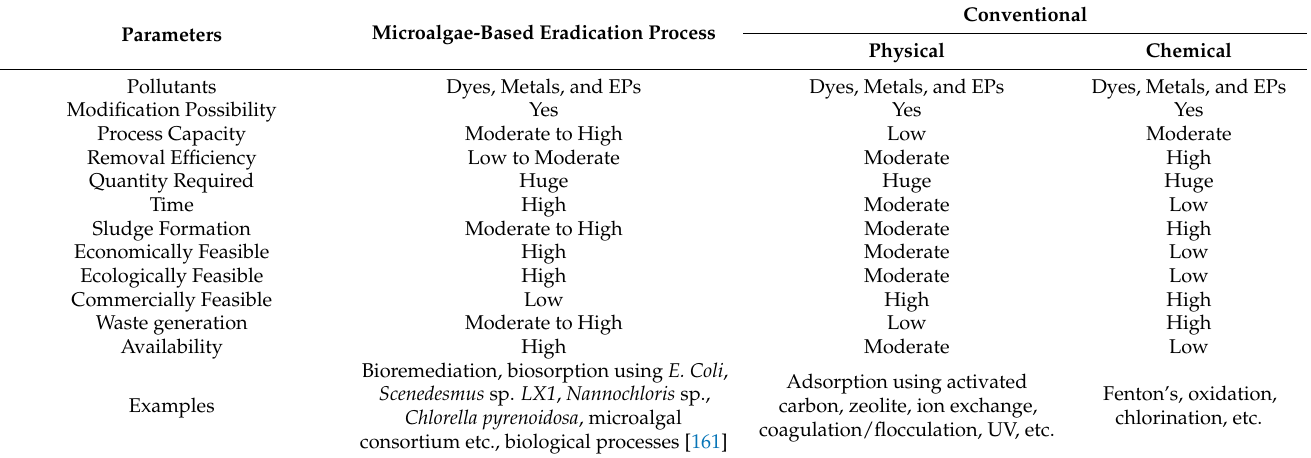
Table 9. Techno-Economical Aspects of Green and Conventional